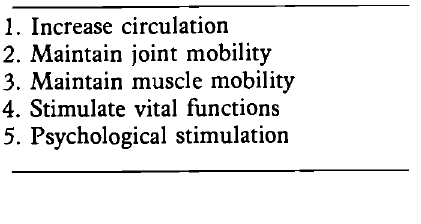
Table 6: Aims of physical